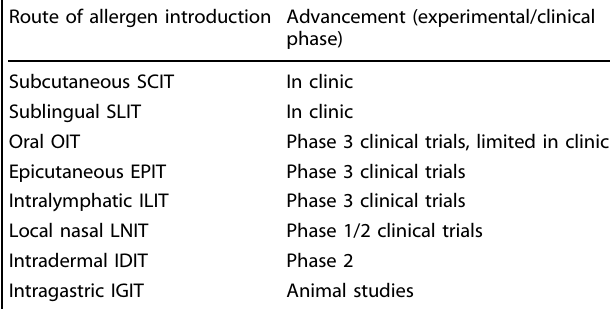
Table 1. AIT routes, currently in clinic or investigated experimentally (based on the current data deposited in ClinicalTrials.gov)